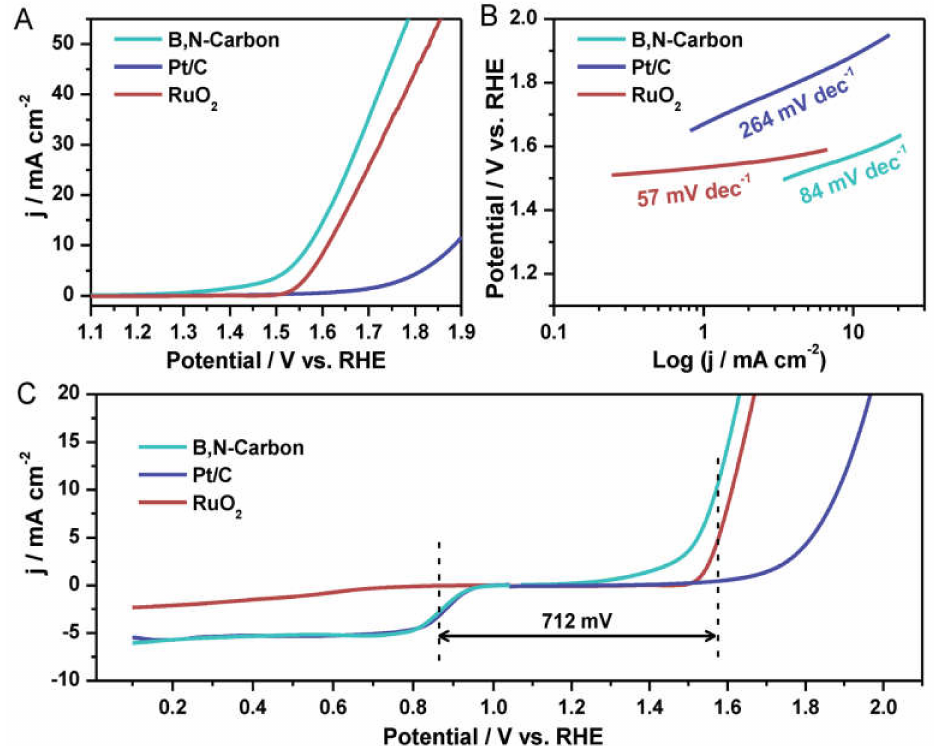
Figure 8. OER performances of the catalysts. ( a ) LSV curves measured at a rotation speed of 1600 rpm with a scan rate of 5 mV s − 1 . ( b ) Tafel plots. ( c ) Bifunctional catalytic activities for ORR and OER in O 2 -saturated 1.0 M KOH. Copyright 2018 by Wiley-VCH Verlag GmbH & Co. Weinheim